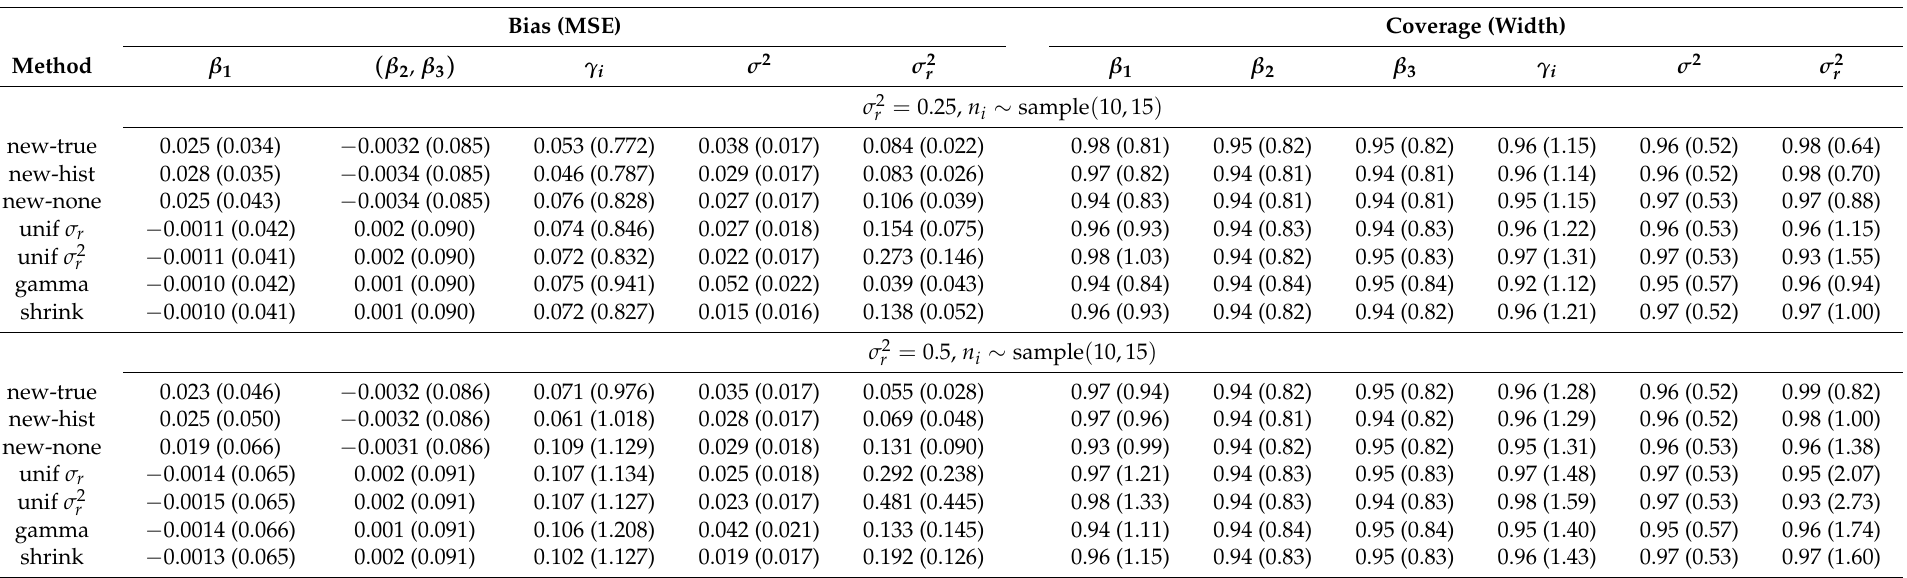
Table 4. Simulation III: Average biases (MSEs), coverage probabilities (interval widths) across 500 MC replicates in the simulation study for random intercept